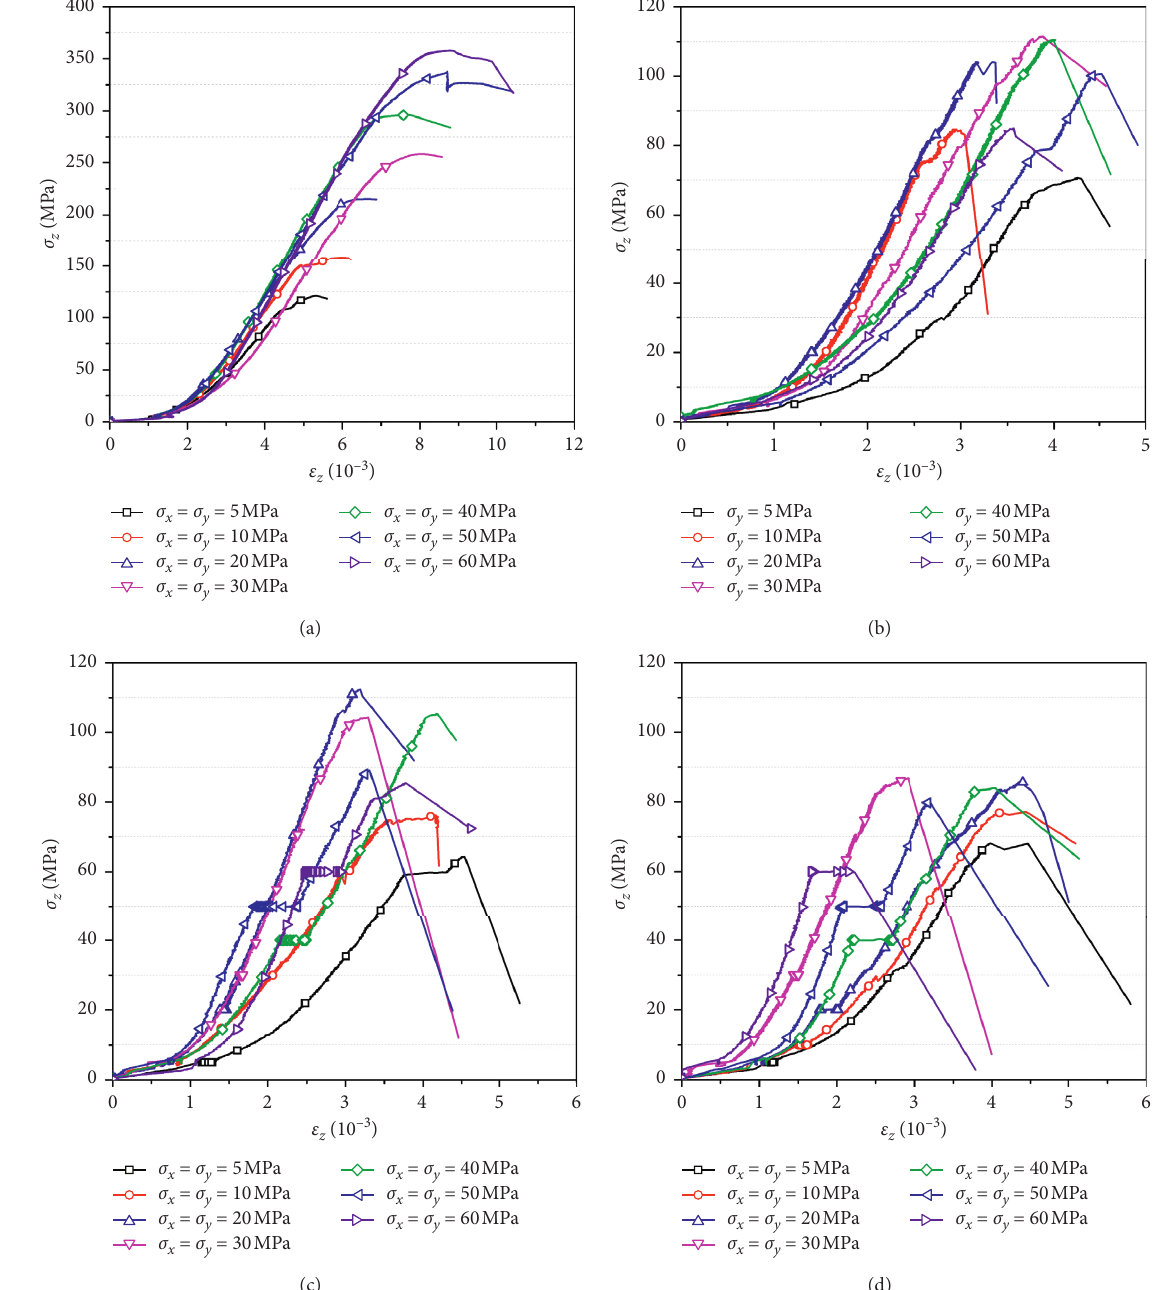
Figure 4: The Z direction stress-strain curve: (a) TCT, (b) BCT, (c) TLU, and (d) THU ( σ directions,